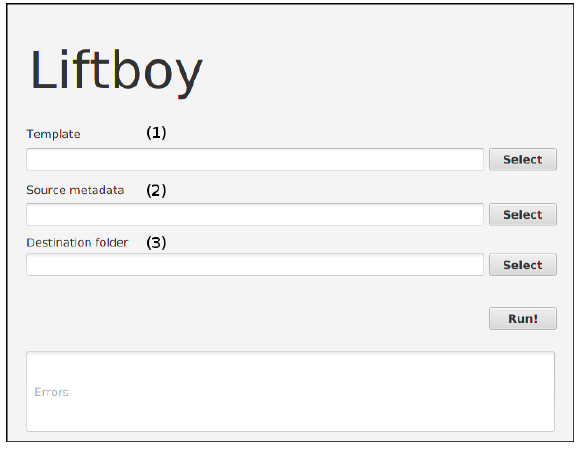
Figure 4. Interface to the Liftboy